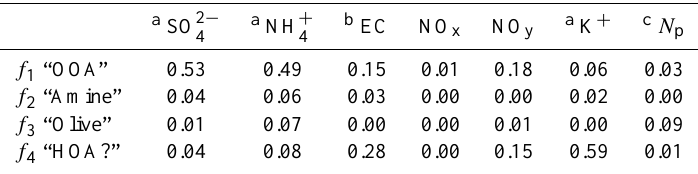
Table A3. Correlations of PMF factors ( f i ) with ancillary data: 4-factor PMF solution.